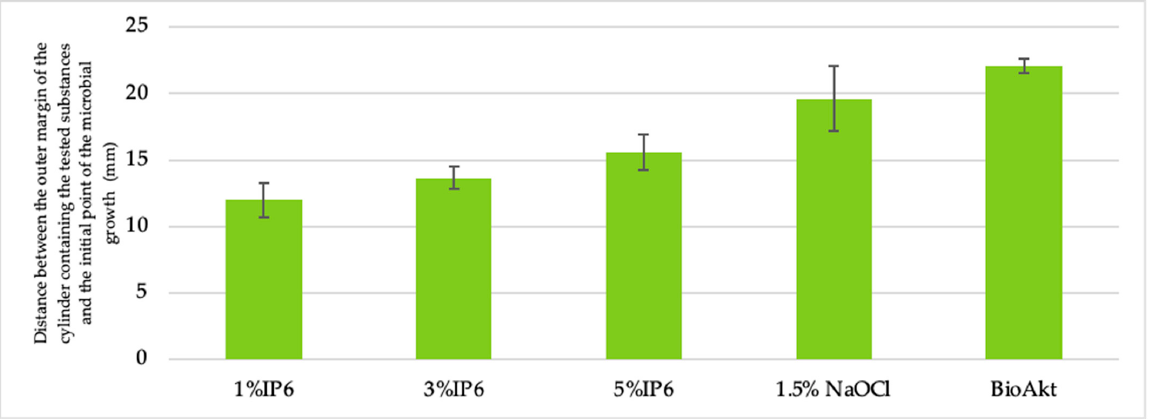
Figure 3. Diffusion test.